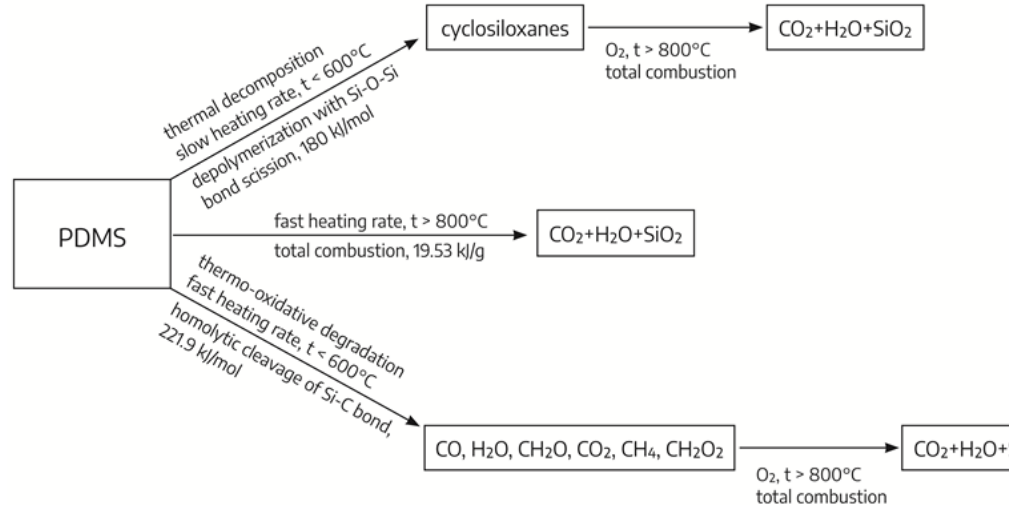
Figure 1. The possible paths of thermal degradation of PDMS depending on external conditions.